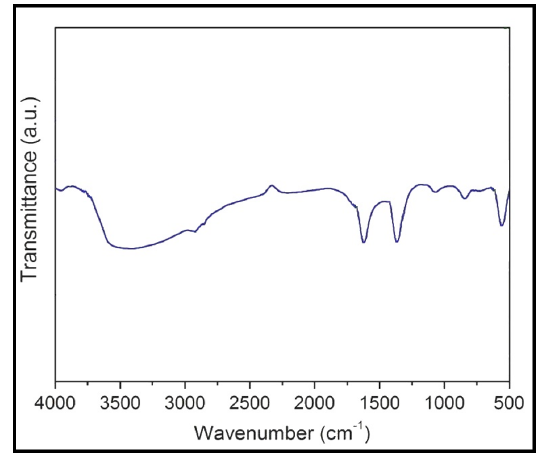
Fig.5. FT-IR spectrum of TiO